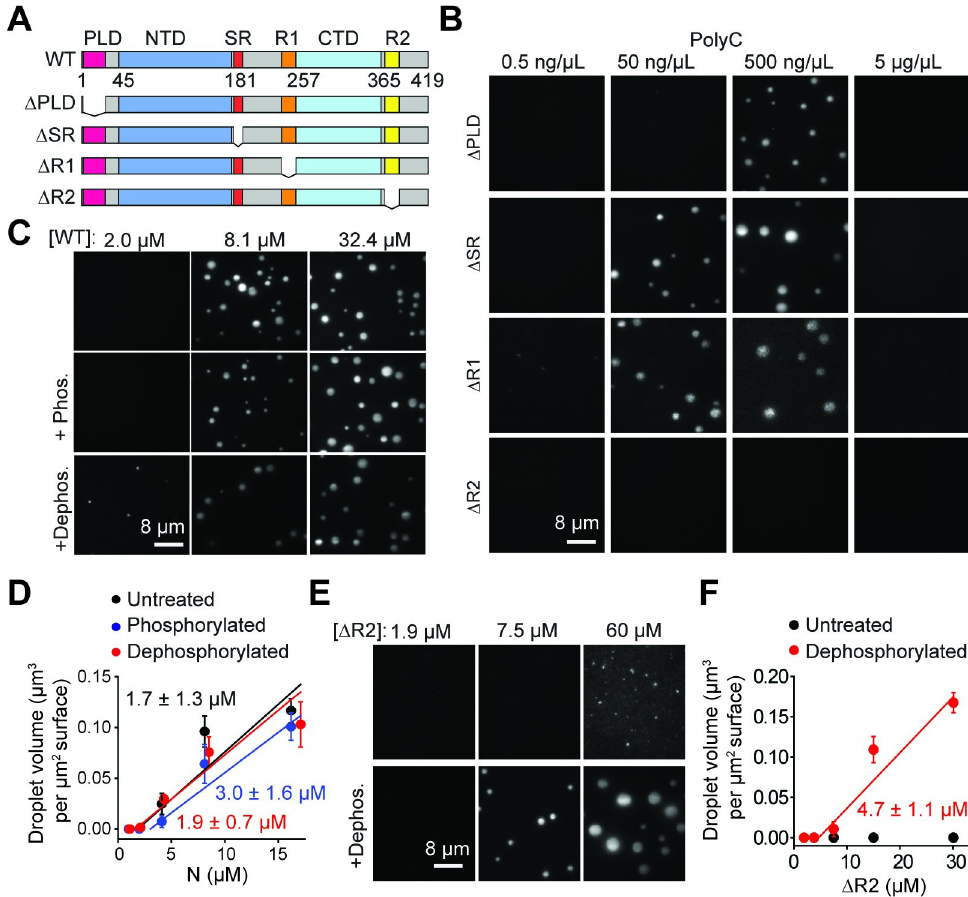
Fig 4. The effect of domain deletions and phosphorylation on phase separation of the N protein. (A) Deletion mutants of the N protein. (B) While Δ PLD, Δ SR, and Δ R1 phase separate, Δ R2 does not phase separate when mixed with polyC RNA. Protein concentration was set at 18 μ M for all conditions. (C) Images of condensates formed by untreated, phosphorylated, and dephosphorylated N protein in 50 ng/ μ L polyC RNA. (D) The total volume of N-RNA condensates settled per micron squared area on the coverslip under different phosphorylation conditions (mean ± SD, n = 20 with 2 technical replicates). Linear fits (solid lines) reveal c sat ( ± SE). (E) Images of condensates formed by untreated and dephosphorylated Δ R2 in 50 ng/ μ L polyC RNA. (F) The total volume of Δ R2-RNA condensates settled per micron squared area on the coverslip as a function of Δ R2 concentration (mean ± SD, n = 20 with 2 technical replicates). The linear fit (solid line) reveals c sat ( ± SE). Data underlying this figure can be found in S1 Data. CTD, carboxyl-terminal domain; N, nucleocapsid; NTD, N-terminal domain; PLD, prion-like domain; SR, serine/arginine-rich; WT, wild-type.